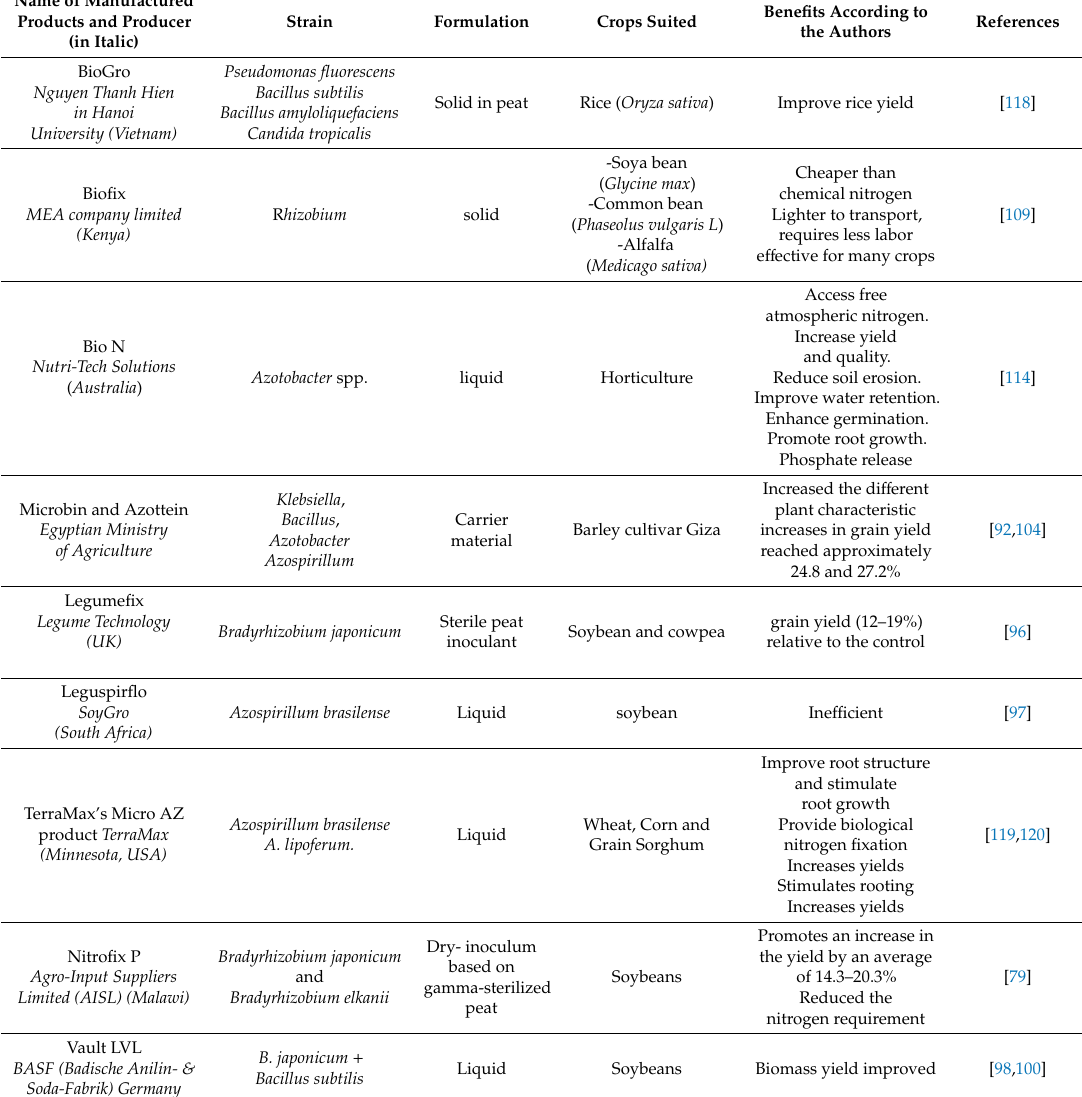
Table 2. Some famous marketed microbe-based biofertilizers and target